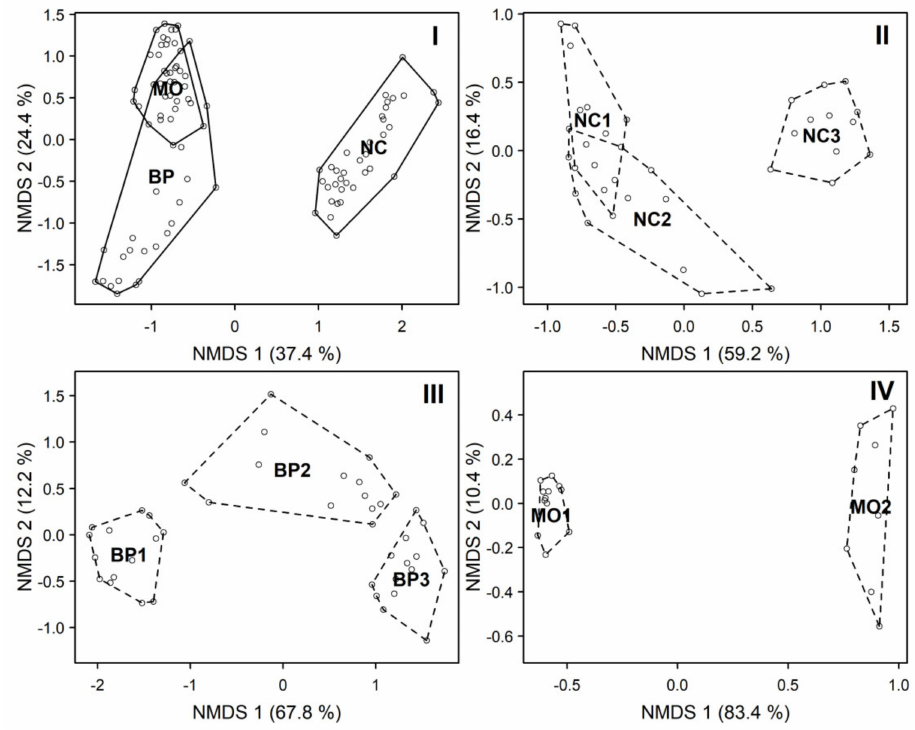
Figure 2. NMDS ordination of the vegetation data. NMDS ordination of the vegetation data. Convex hulls enclose ( I ) study areas: NC—Northwest Caucasus, MO—Moskva-Oka plain, BP—Bryansk Polesie. ( II ) Forest types in NC: NC1—hornbeam–aspen, NC2—hornbeam–fir–beech, NC3—beech– fir. ( III ) Forest types in BP: BP1—pine, BP2—pine–broadleaf, BP3—broadleaf–spruce. ( IV ) Forest types in MO: MO1—lime–birch,